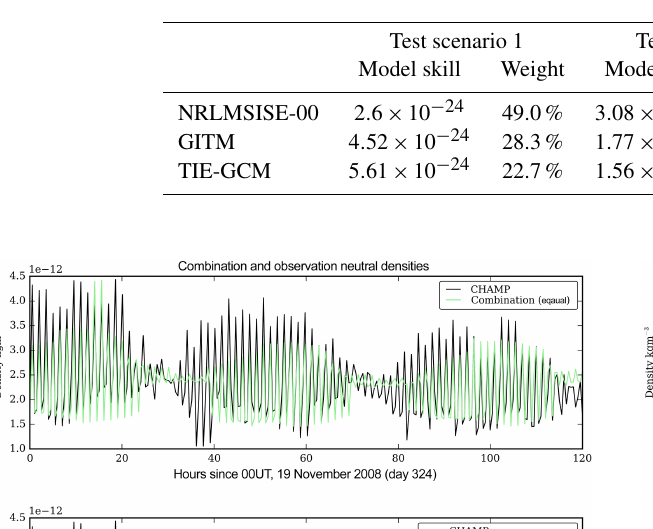
Table 2. Model skill and associated weighting (calculated by the inverse of model skill, Eq. 2) for use in the weighted MMEs for the three test scenarios.